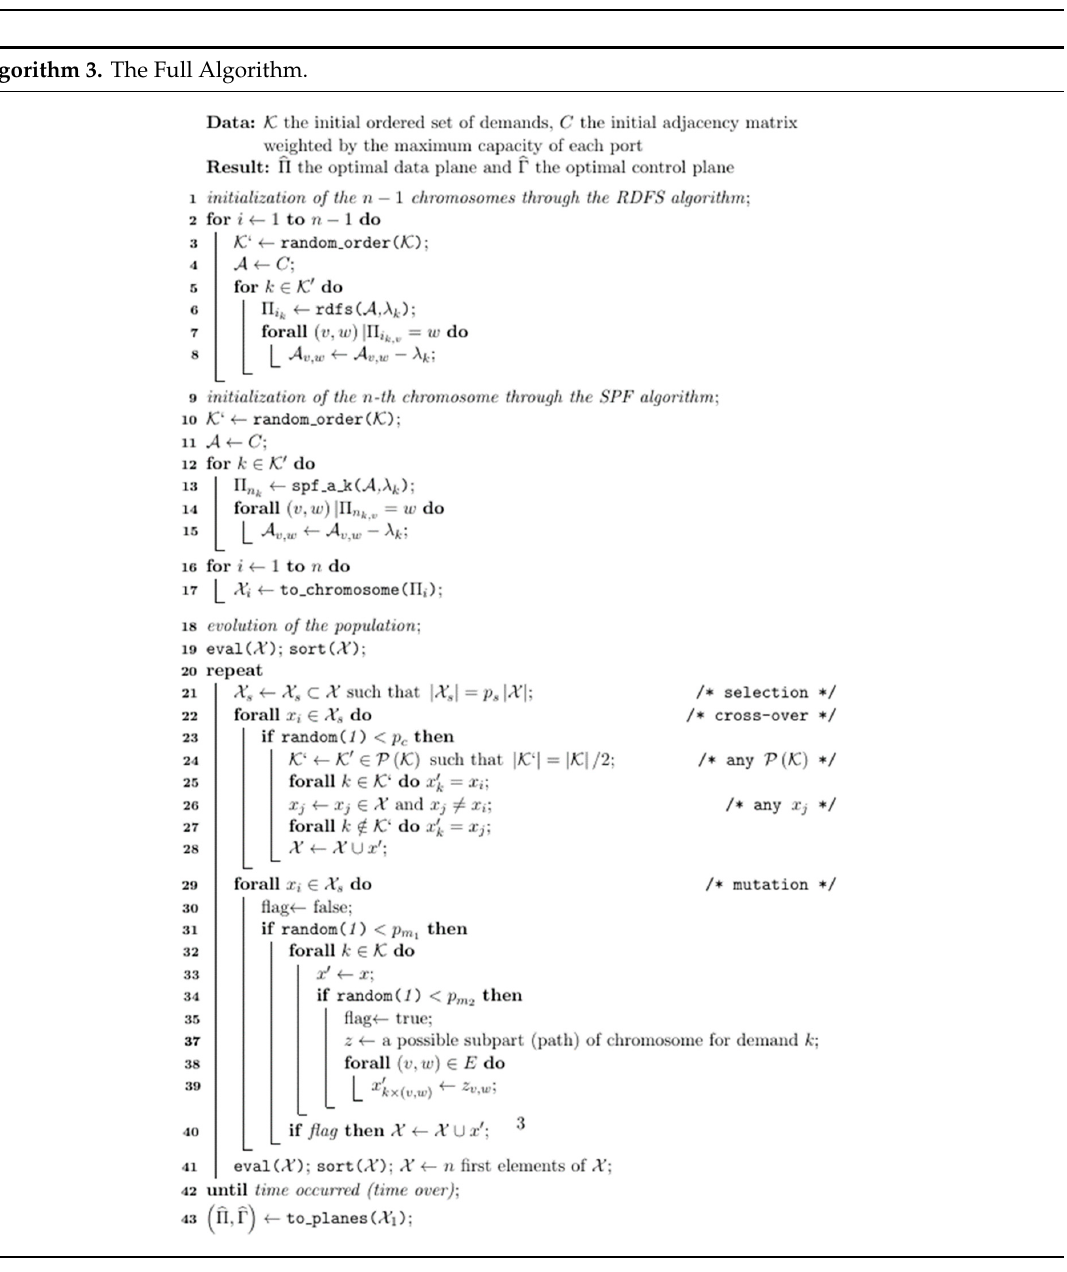
Algorithm 3. The Full